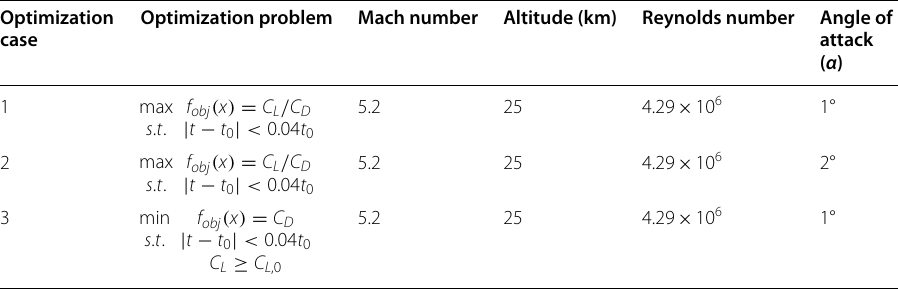
Table 9 Design cases for wing profile optimization Optimization